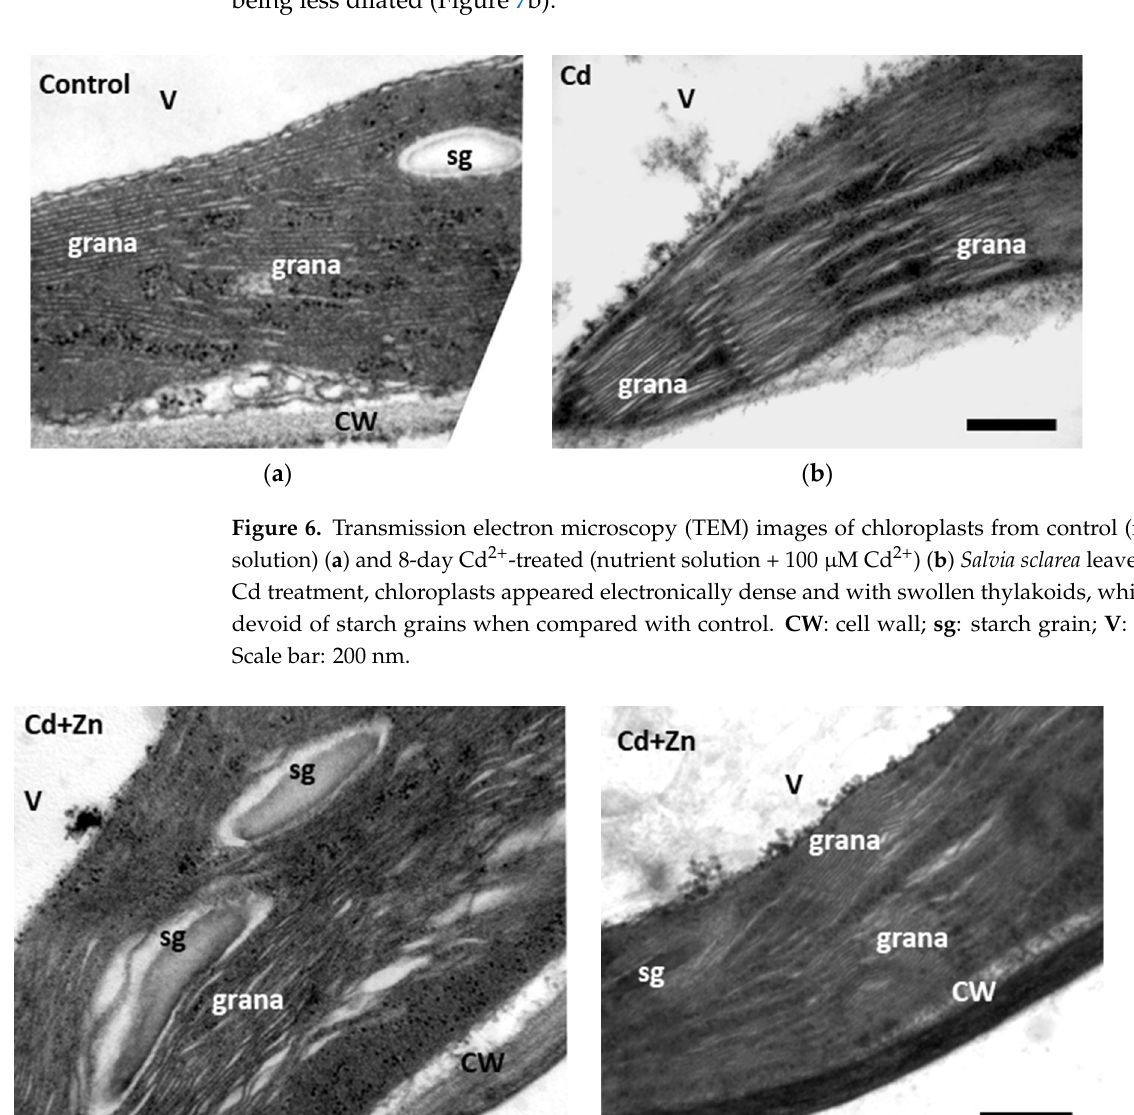
Figure 5. Changes in the level of lipid peroxidation, assessed by the accumulation of malondialde- hyde (MDA) ( a ), and the generation of hydrogen peroxide (H 2 O 2 ) ( b ), in the leaves of Salvia sclarea control (nutrient solution), Cd 2+ (nutrient solution +100 μ M Cd 2+ ), and Cd 2+ + Zn 2+ (nutrient solution +100 μ M Cd 2+ + 900 μ M Zn 2+ ). Error bars are standard deviations ( n = 5). Columns with different lowercase letters are statistically different ( p < 0.05).